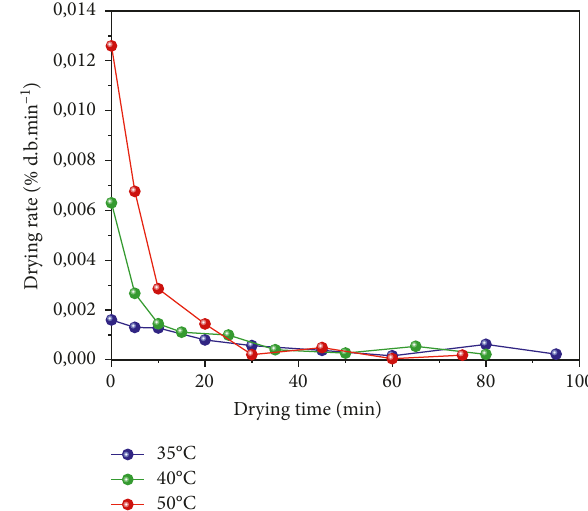
Figure 2: Variation of moisture content as a function of drying time for three temperatures of Crocus sativus L.